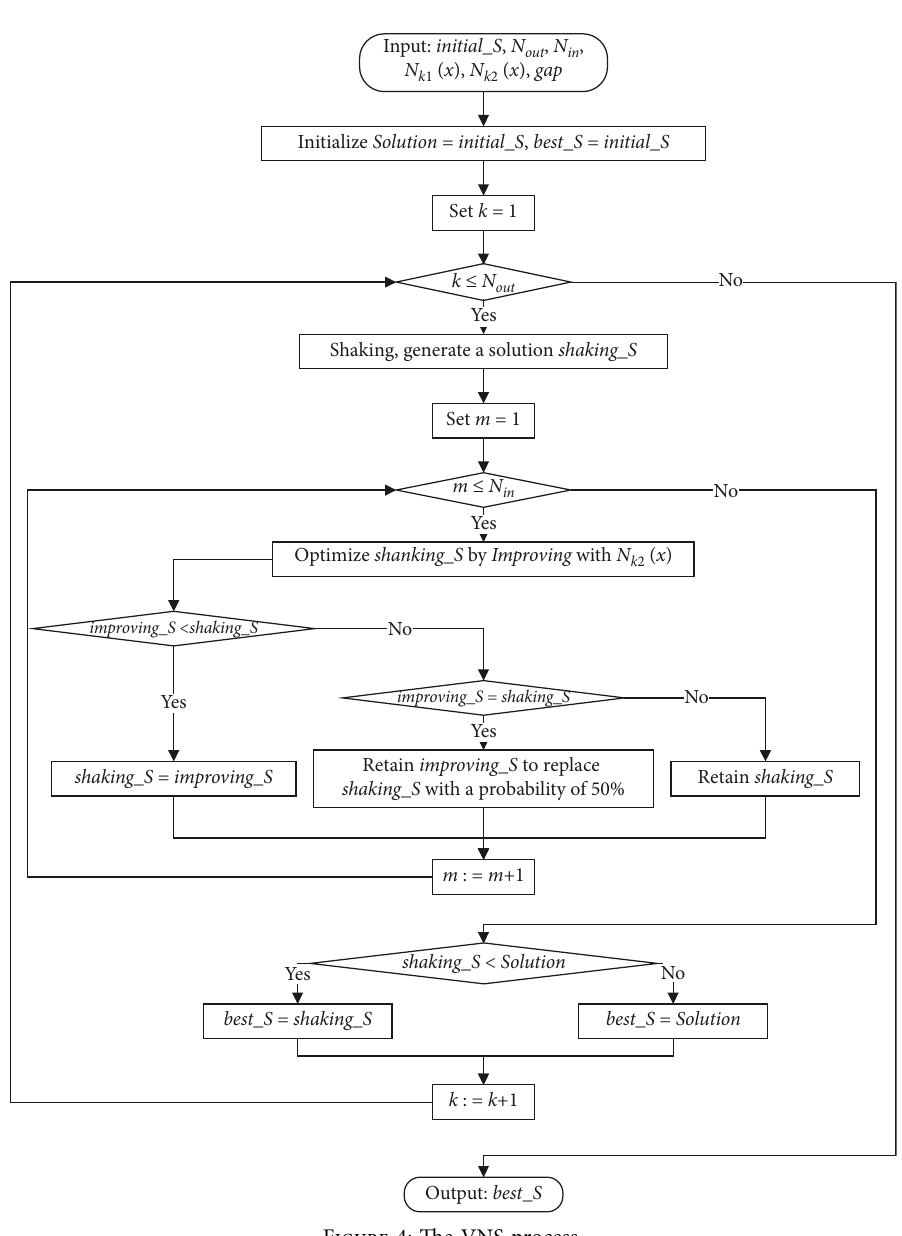
Figure 4: The VNS